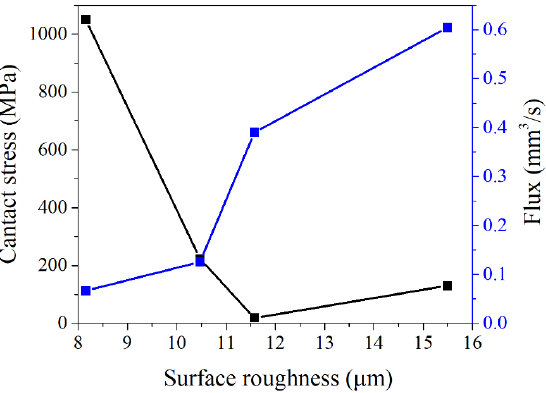
Figure 12. The relationship between surface roughness and contact stress and leakage rate.